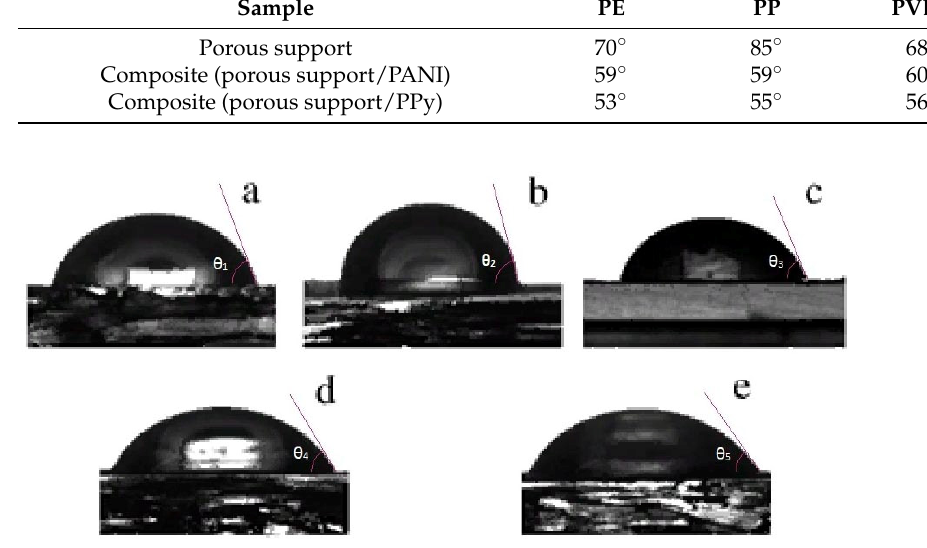
Figure 6. Contact angles for the water-wetted surfaces of porous supports ( a – c ) and composites ( d , e ): PE ( θ 1 ), PP ( θ 2 ) and PVDF ( θ 3 ) supports; (PP support/PANI) ( θ 4 ), and (PP support/PPy) ( θ 5 ) composites.